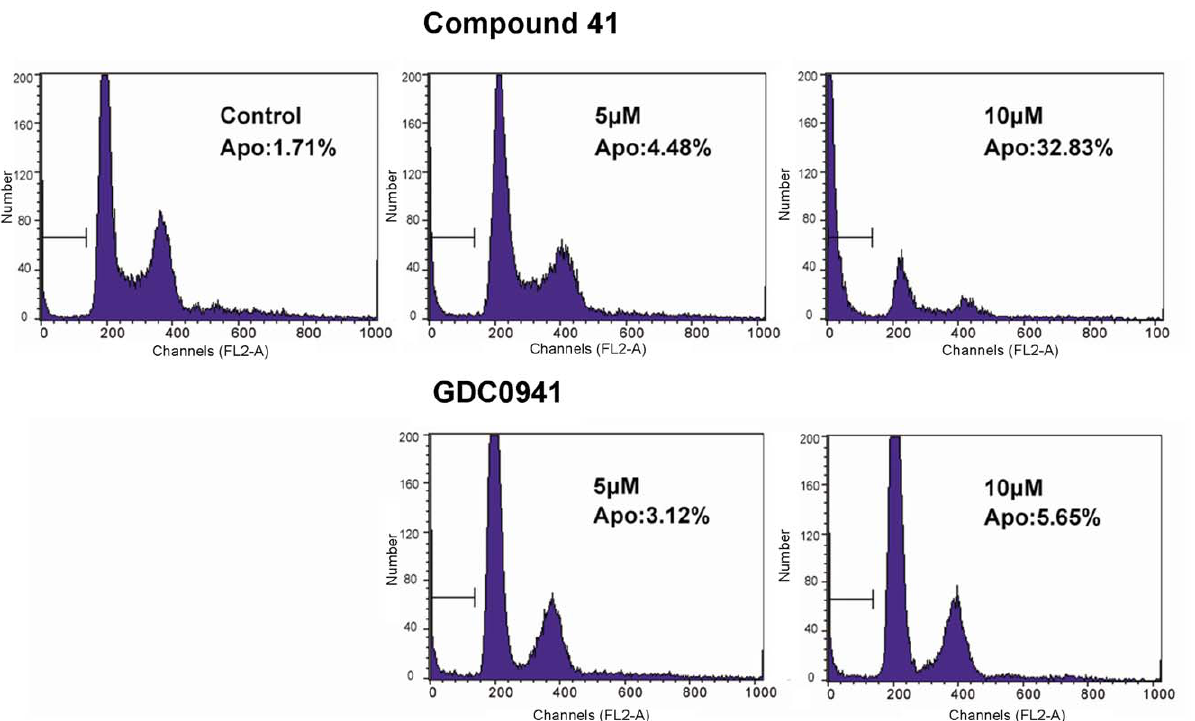
Figure 5. Apoptosis induction of compound 41 and GDC0941 in PC3 cells. After treatment with 41 and GDC0941 (5 or 10 m M) for 24 h, PC3 cells were harvested and detected of apoptosis by flow cytometry using PI apoptosis detection kit. Vertical axes stand for the counts of relative number of PC3 cells; horizontal axes stand for the relative fluorescence light intensity measured as pulse-area (FL2-A). doi:10.1371/journal.pone.0043171.g005 PLOS ONE |